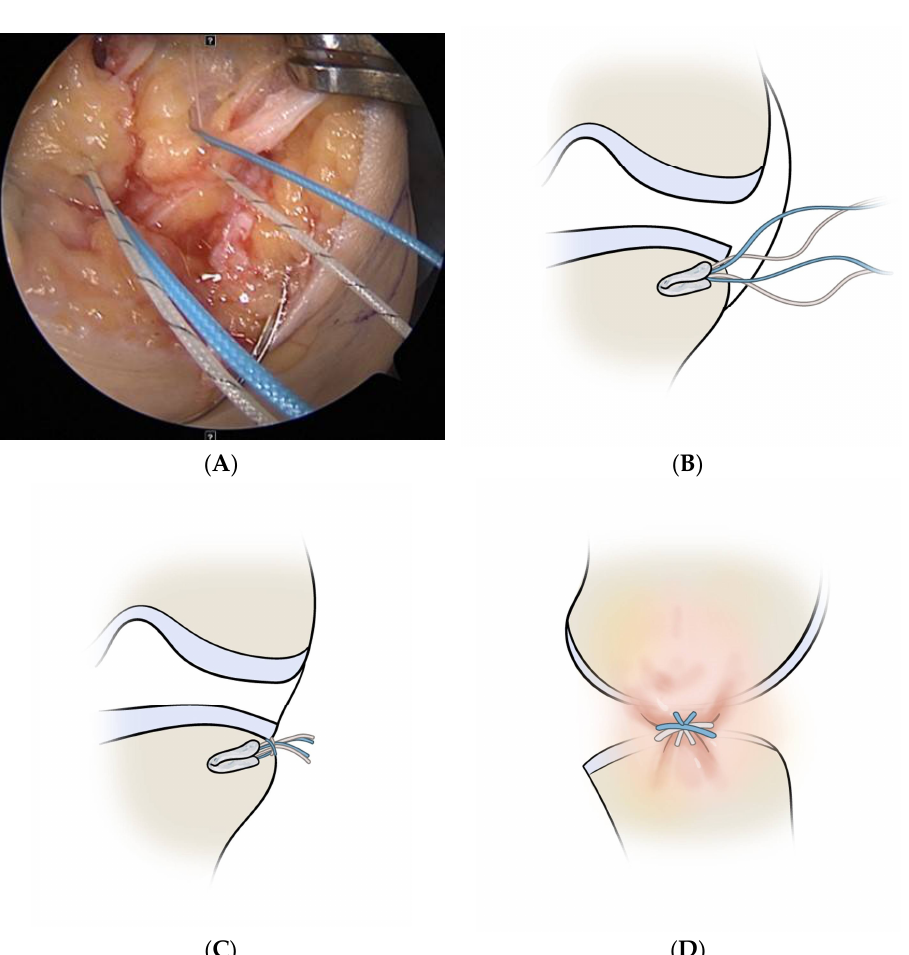
Figure 2. All-soft suture anchor is inserted slightly anterior to the midbody level of the lateral me- niscus.